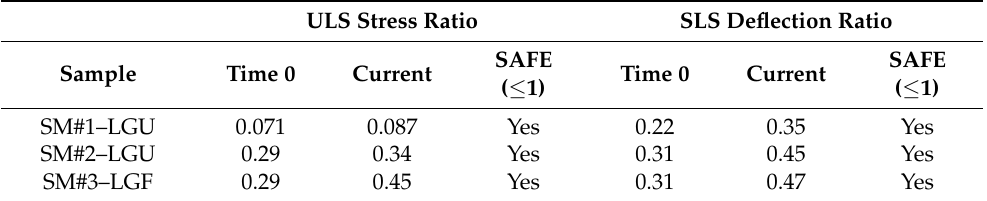
Table 6. Safety check for ULS stress and SLS deformation accounting for in-field experimentally derived degradation phenomena for the examined LG modular